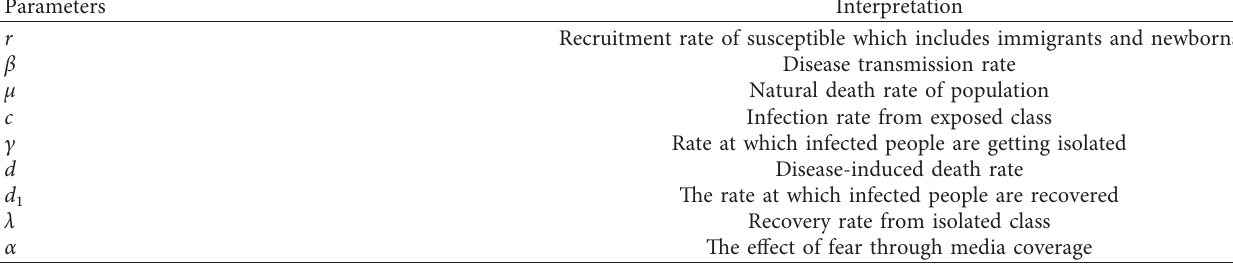
Table 1: Parameters and their